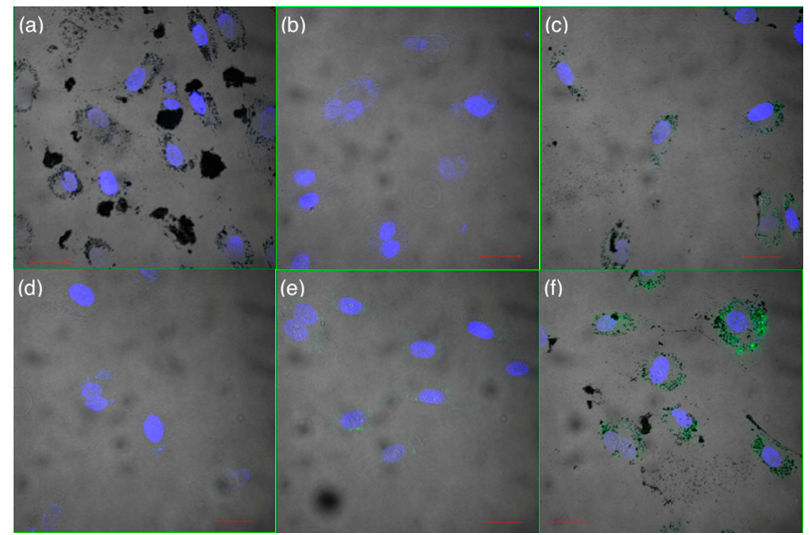
Figure 10. LSM merged micrographs of fluorescence (blue: DAPI; green: FAM) and optical bright field of HUVECs 24-h treated with ( a ) 2.5 nM bare AuNP; ( b ) 75 nM VEGFGlyFAM; ( c ) AuNP/VEGFGlyFAM; ( d ) 25 nM VEGFCysFAM; ( e ) 75 nM VEGFCysFAM; ( f ) AuNP/VEGFCys- FAM.